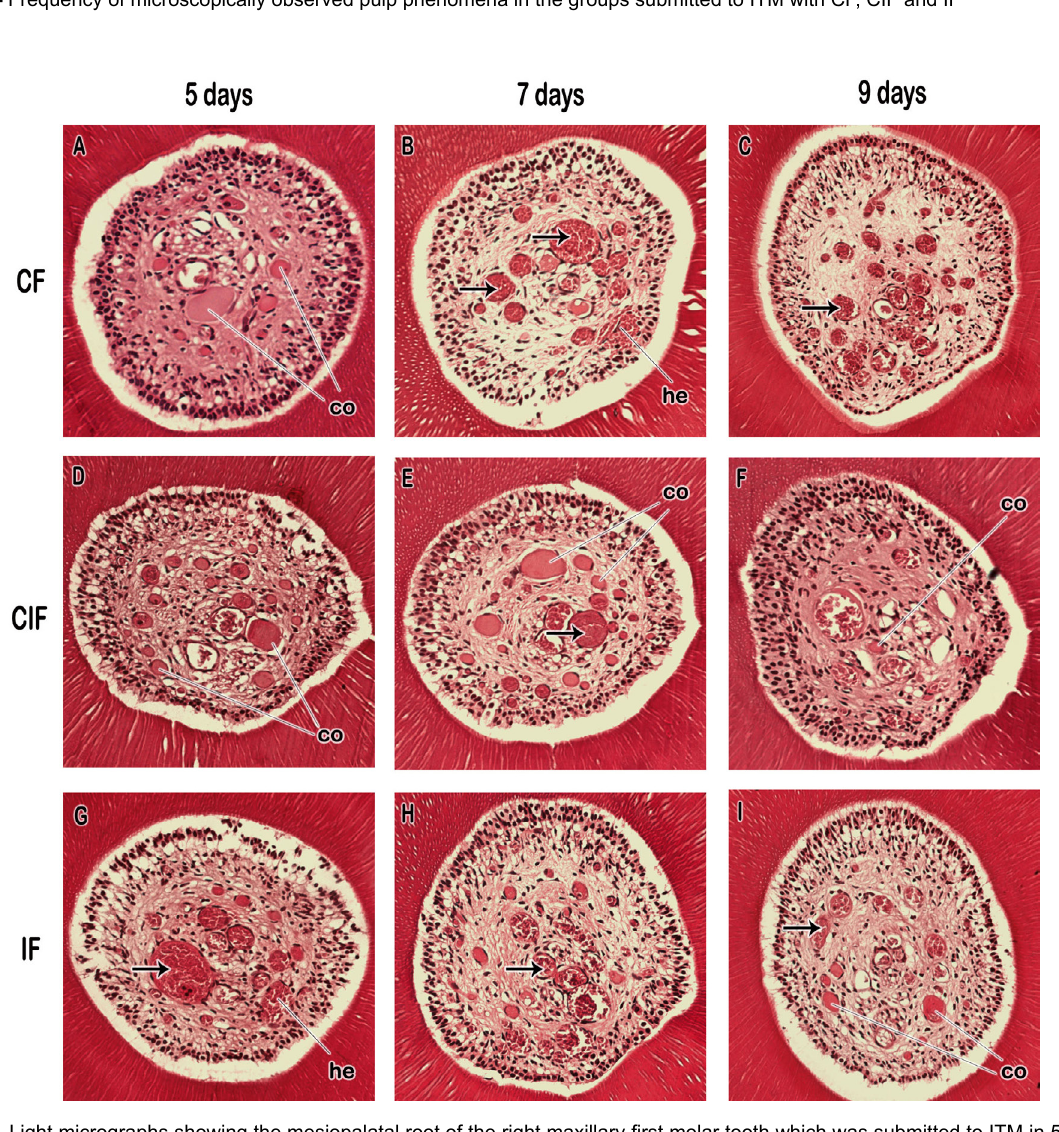
Figure 5- Light micrographs showing the mesiopalatal root of the right maxillary first molar tooth which was submitted to ITM in 5, 7 and 9 days with continuous force (CF), continuous interrupted force (CIF) and intermittent force (IF). Evidence of thrombosis in black arrow, vascular congestion (co) and hemorrhage (he). Hematoxylin and eosin magnified